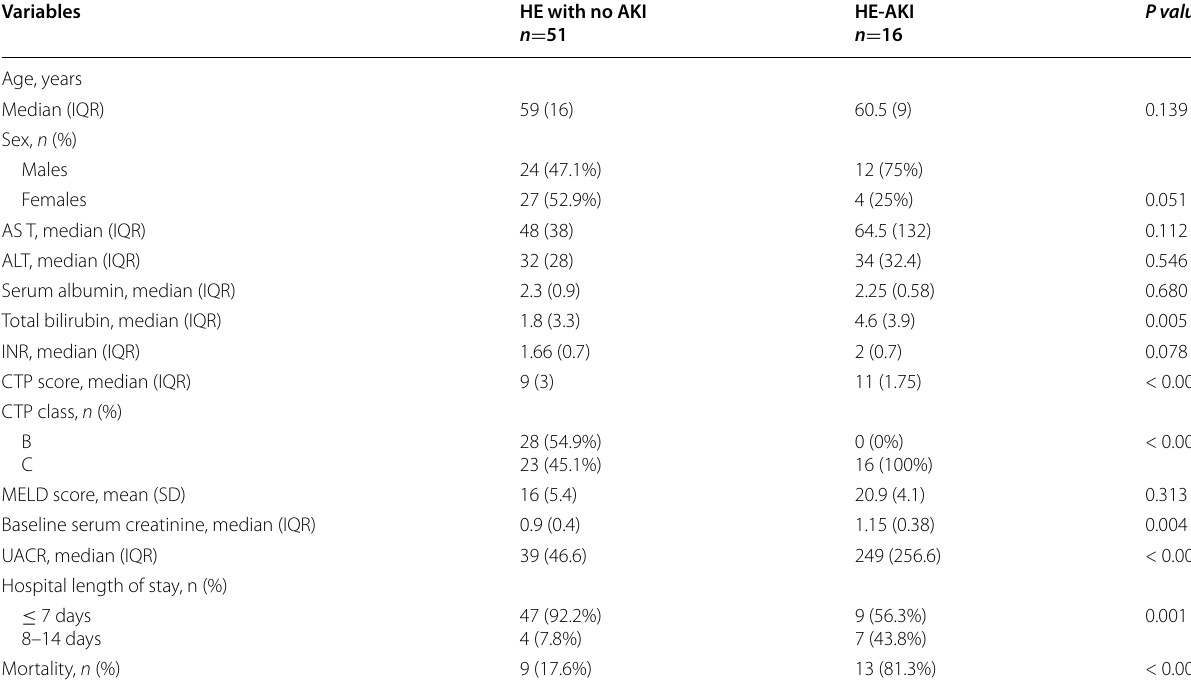
Table 3 Baseline characteristics of patients with HE without AKI versus those with